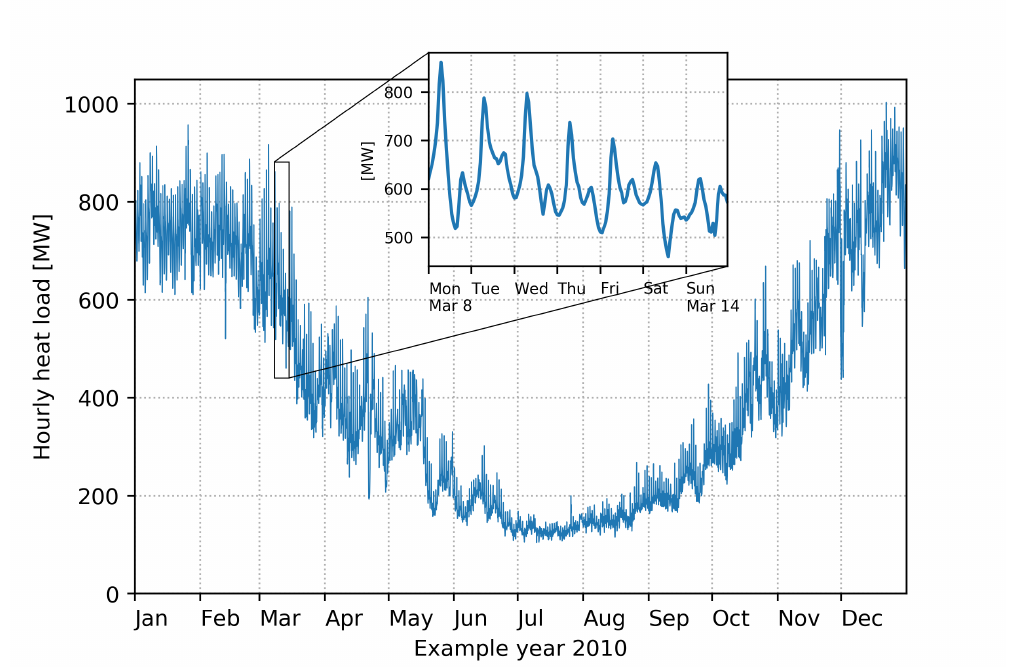
Figure 2. Time series for the hourly heat load in the year 2010. The inset shows a zoom of a week in March. The heat demand has peaks in its autocorrelation function at 24 h, 48 h, 72 h, and so on. This is due to the strong daily pattern. There is also a notable peak at 168 h (one week). In order to capture this behavior, lagged values of the heat load were used as input variables in the modeling. Specifically, we included the heat load lagged with 24 h, 48 h, and 168 h. Looking at Figure 1, we see that the forecast horizon varies between 15 h and 38 h. The heat load in the first hour of the day can be forecasted with the shortest horizon, and the last hour of each day is forecasted with the longest horizon. When forecasting hours with a forecast horizon of 24 h or less, the heat load lagged 24 h can be used. When forecasting hours with a longer horizon than 24 h, the heat load lagged with 48 h must be used instead. A power spectrum analysis confirmed strong peaks at frequencies 1/12 h − 1 and 1/24 h − 1 , but 12 h is shorter than the shortest forecast horizon and was thus discarded. The two lags that best captured the daily and weekly pattern of the heat load were included. We denote the lagged heat load by P t − 24 , P t − 48 , and P t − 168 ,